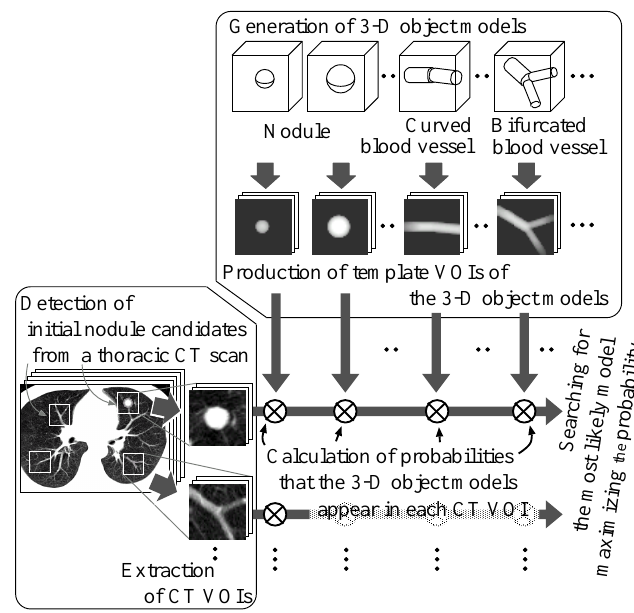
Figure 1. The process of the proposed